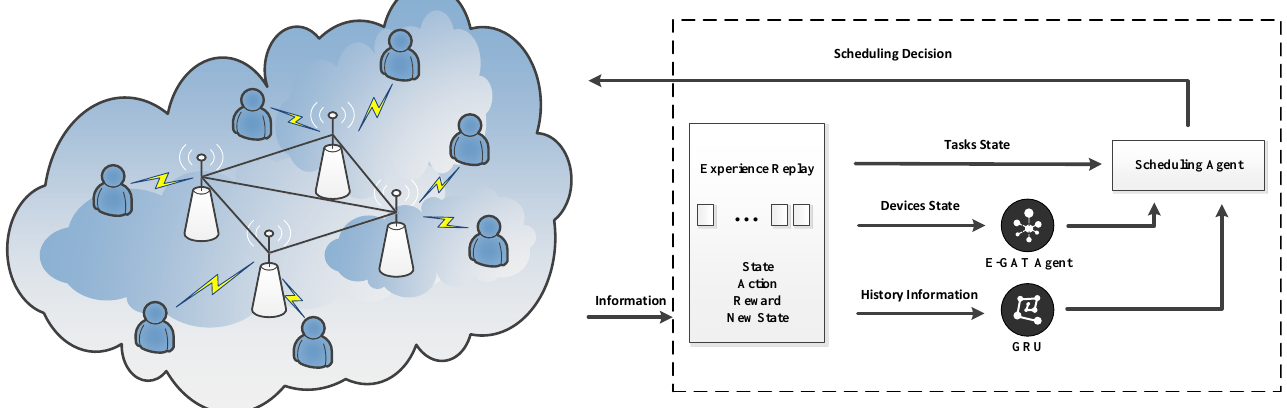
Figure 3. Model–Scenario interaction